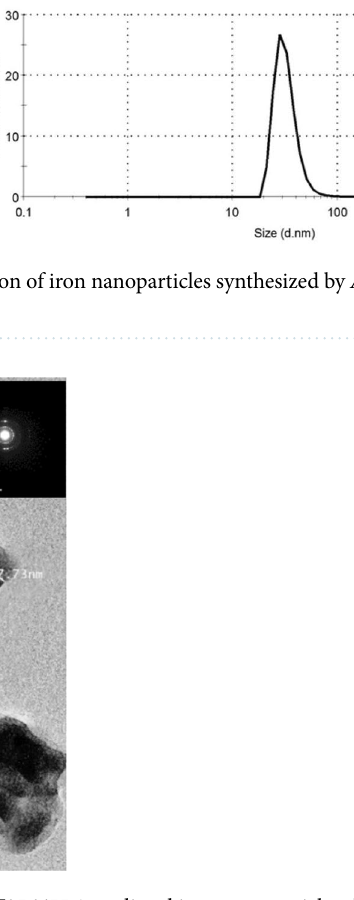
Figure 7. TEM image of Aspergillus flavipes MN956655.1 mediated iron nanoparticles showing the electron diffraction pattern on the